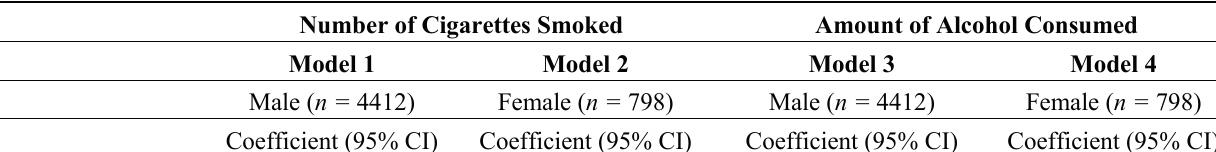
Table 3. OLS regression estimates of number cigarettes smoked and amount of alcohol consumed among dual consumers ( n = 5210): CLHLS, 1998–2008 a